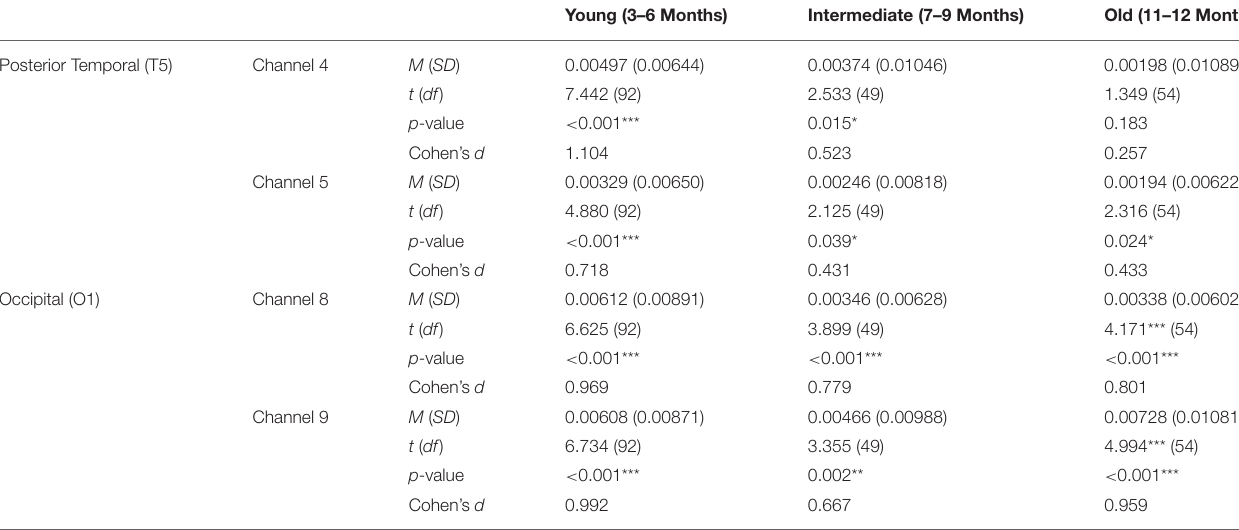
TABLE 1 | Mean (SD) HbO responses for the young, intermediate, and old age groups of Experiment 1.